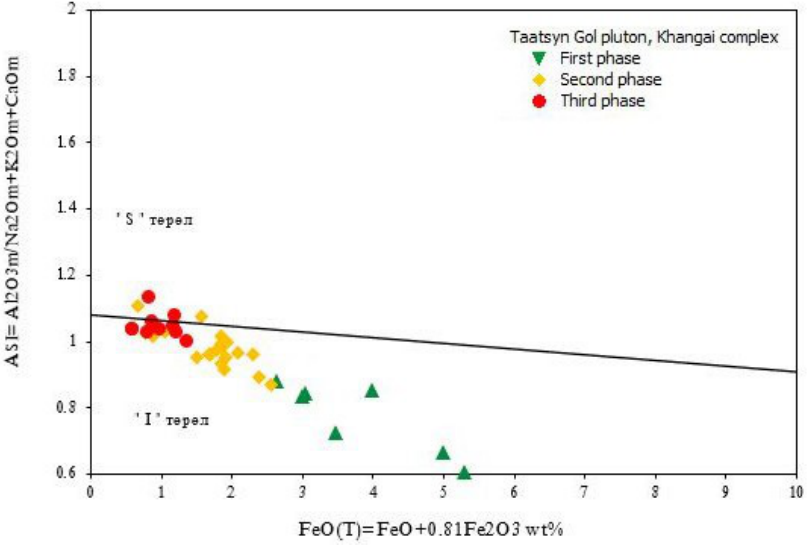
Fig 18. FeO (T) -ASI diagram of the Taatsiin Gol pluton, Khangai Complex (Pearce et al.,